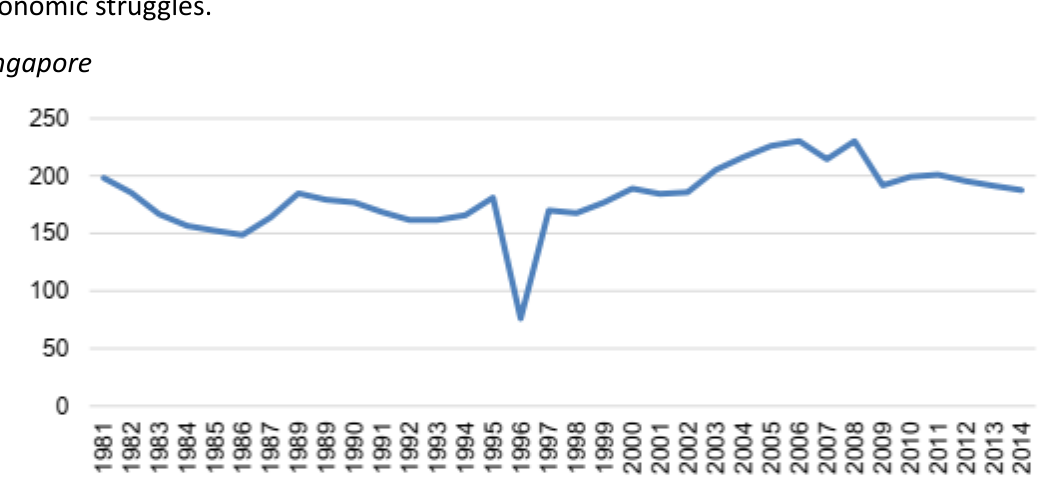
Figure 3: Exports (percentage of GDP) of Singapore